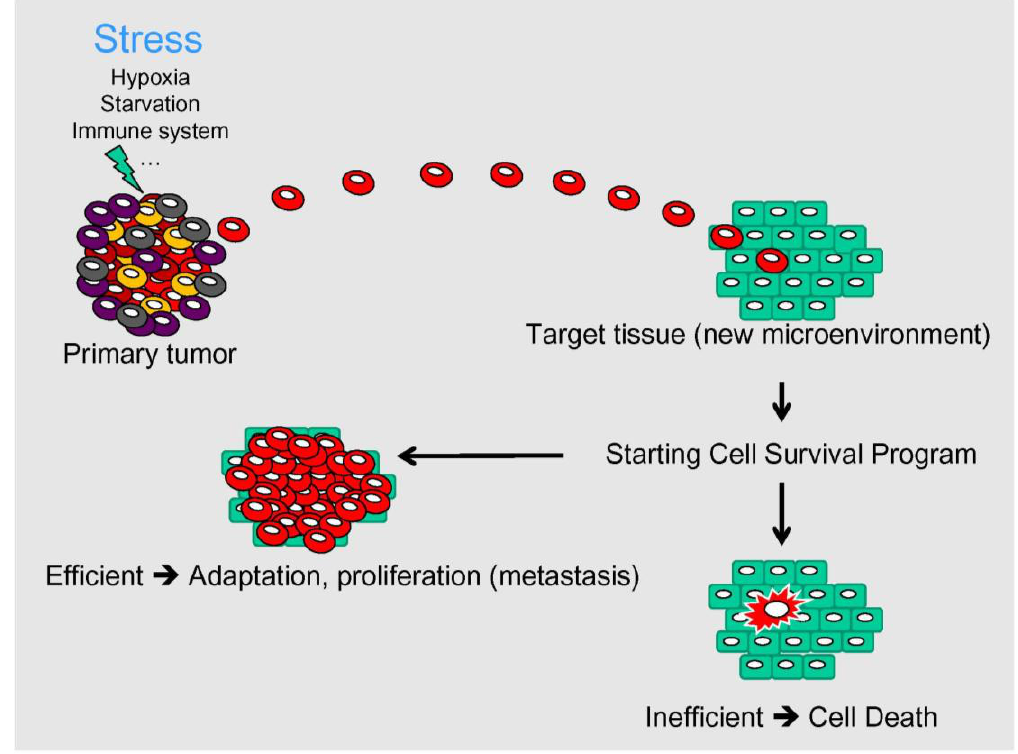
FIGURE 1. Model of microenvironmental stress-driven selection of metastatic cancer cells. Metastasis implantation and growth is preceded by at least two waves of cancer cell selection. The first wave is triggered within the primary tumor as malignant cells disrupt their original tissue and grow away from the vessels, rapidly becoming starved of nutrients and oxygen. As a response to these adverse conditions, cancer cells launch a transcriptional response. Only those cells whose gene expression profile confers efficient resistance to starvation, apoptosis, poor immunogenicity, and migratory skills will be allowed to leave the primary tissue and to travel through the blood stream. The second selection wave is triggered by the specific features of the invaded organ. Similar to the first wave, the genetic response is established in cancer cells in order to adapt and to grow within the invaded tissue. Failure to establish a suitable genetic profile (and the related phenotype) in response to stress will lead to deletion of the cancer